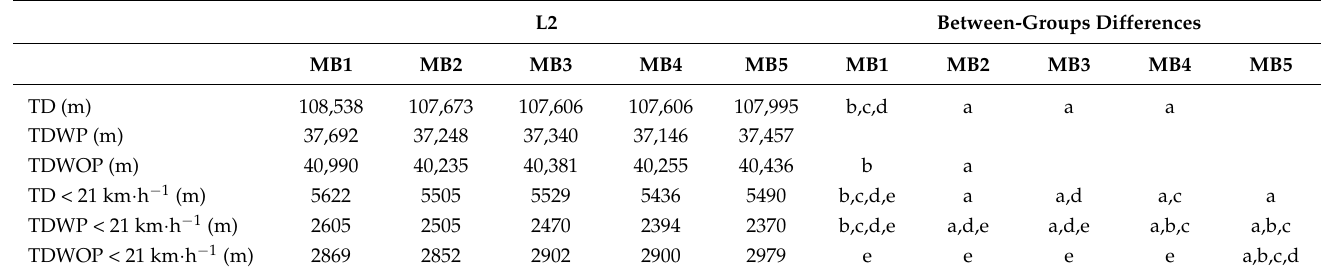
Table 2. Movement profiles based on quality of the opponent in LaLiga Smartbank.